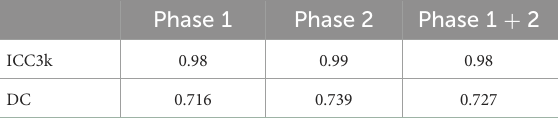
TABLE 1 Inter-rater